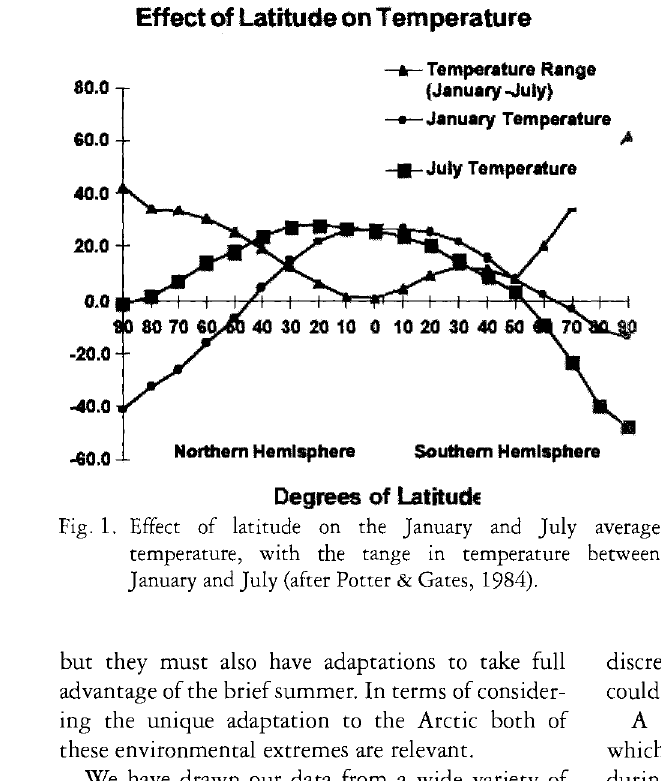
Fig. 1. Effect of latitude on the January and July temperature, with the tange in temperature January and July (after Potter & Gates,